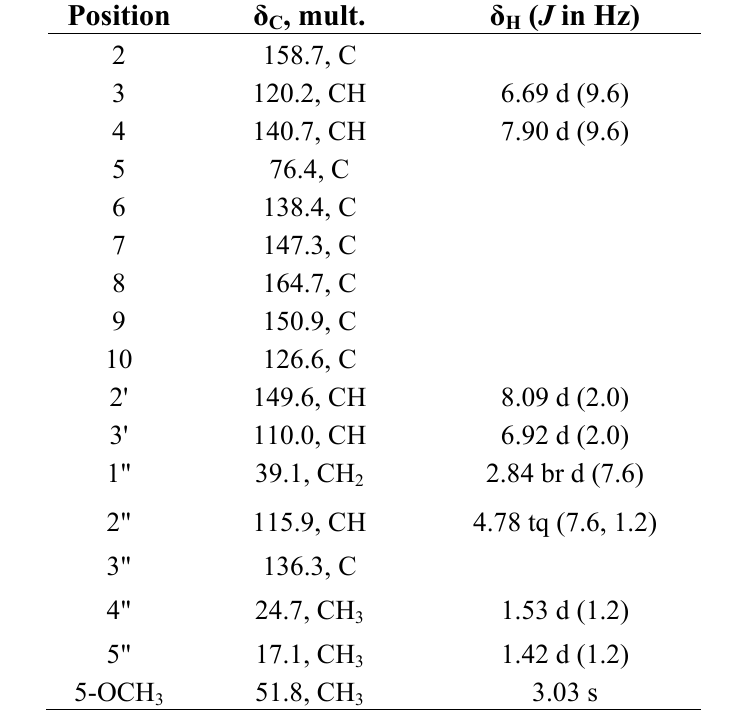
Table 1. 1 H ‑ NMR and 13 C ‑ NMR data of compound 1 (Acetone- d4 , 400 MHz).